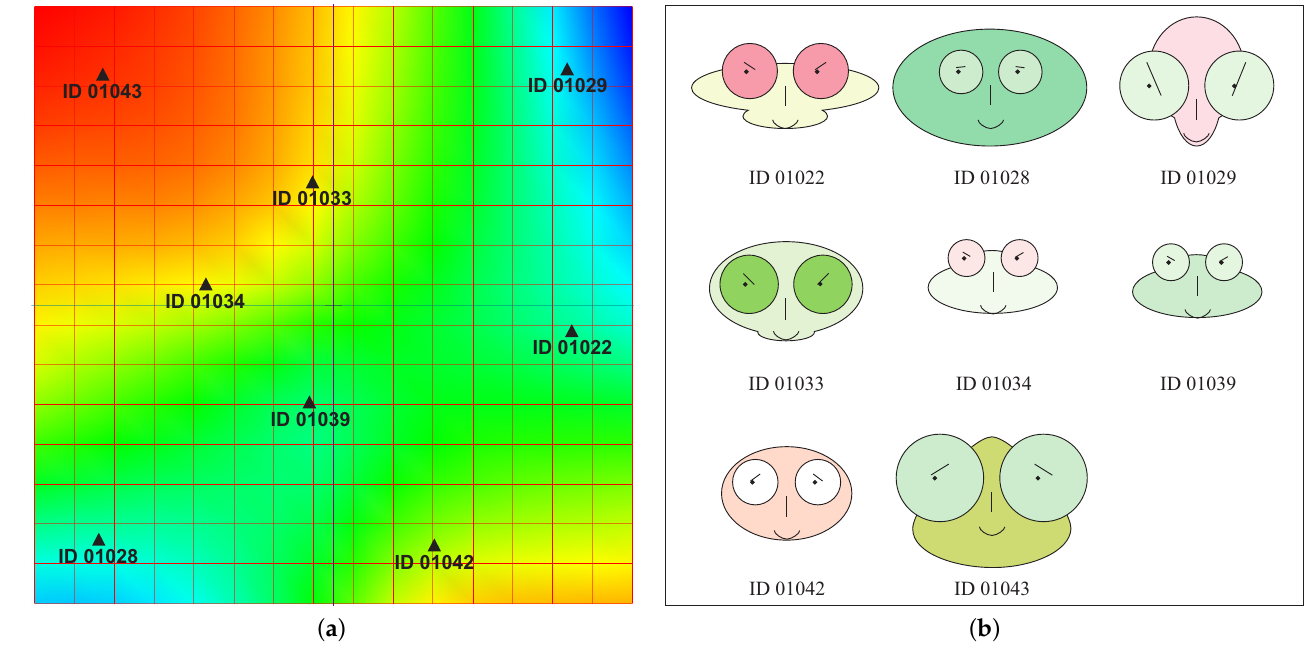
Figure 13. Visualization of a dataset fragment using the elastic maps method ( a ) and the Chernoff faces method ( b ) for the studied student group in the competence aspect (competence OK